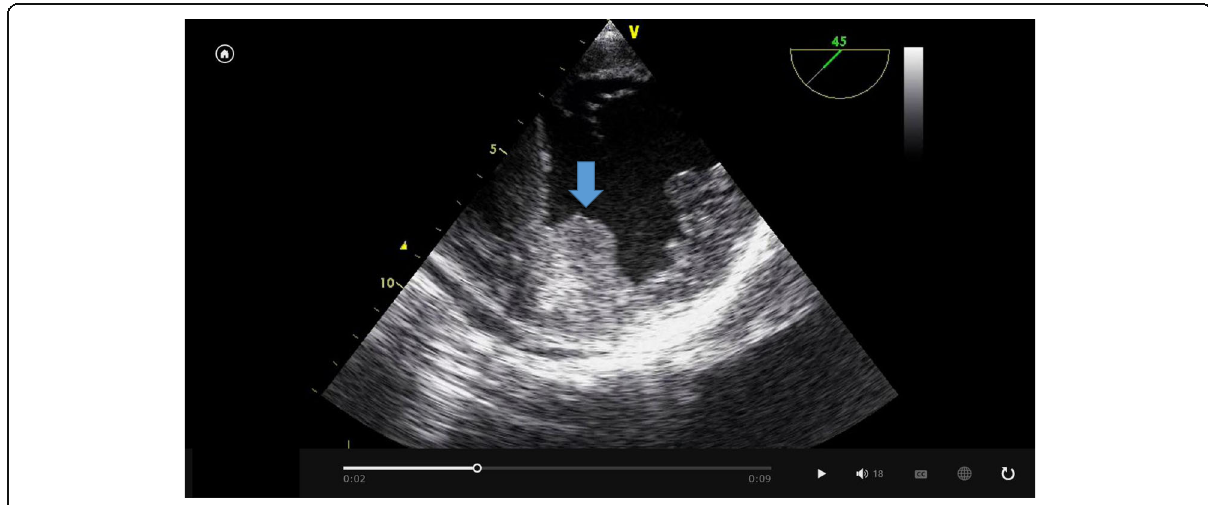
Fig. 1 Left ventricular thrombus observed by transesophageal echocardiography under general anesthesia. The thrombus ( ) was mobile